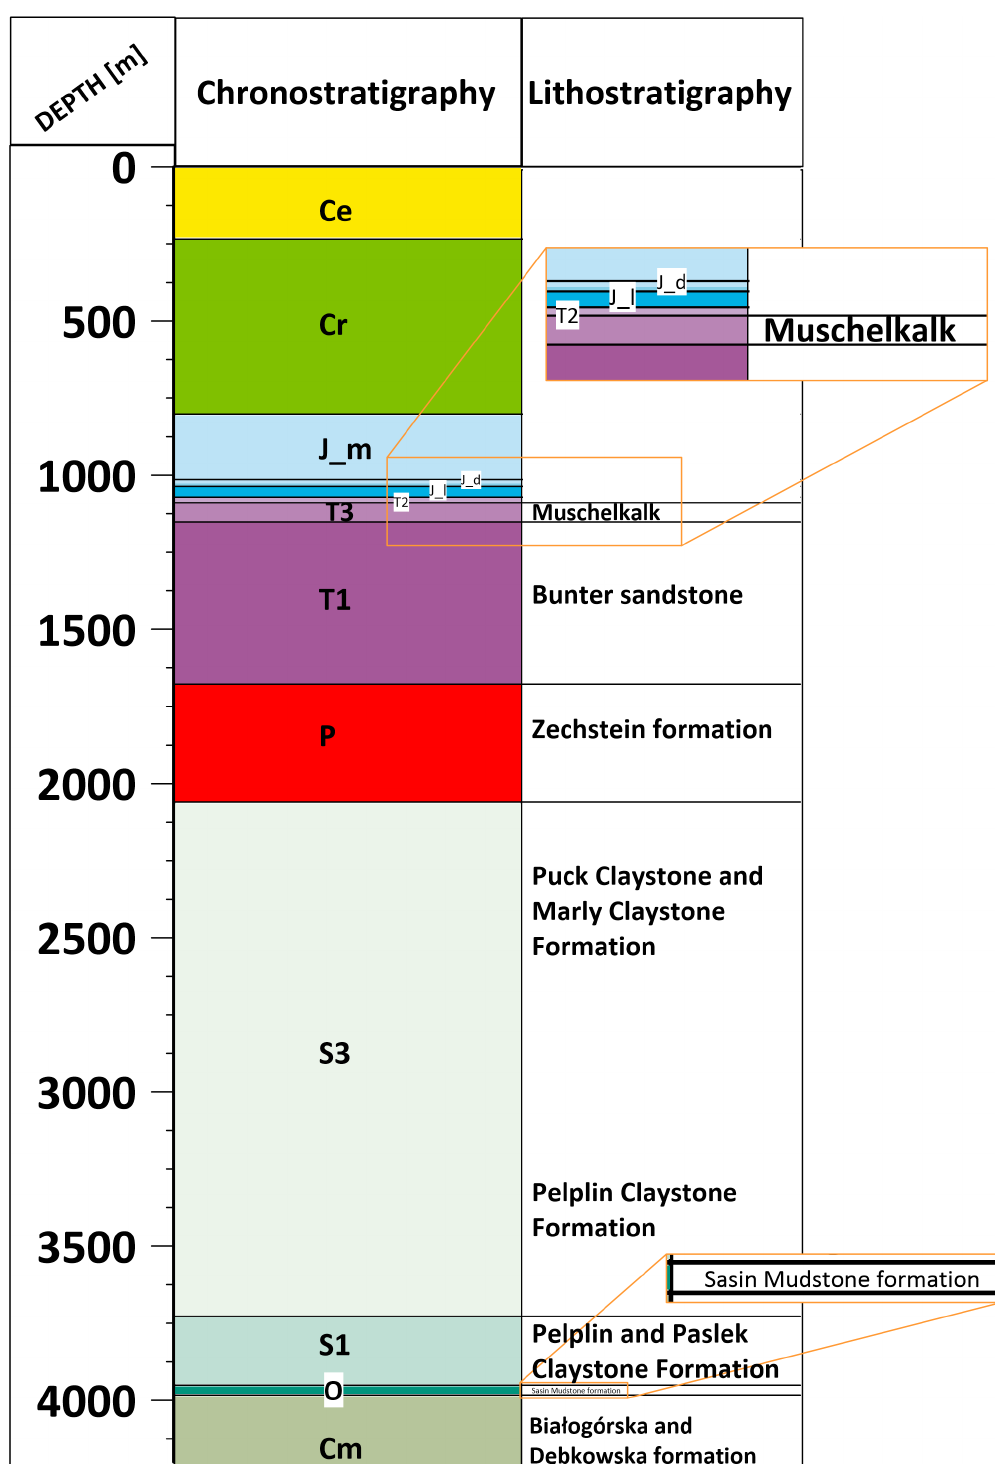
Figure 2. Chronostratigraphic and lithostratigraphic units in well W-1. Cm—Cambrian, O—Ordovician, S1—Lower Silurian, S3—Upper Silurian, P—Permian, T1—Lower Triassic, T2—Middle Triassic, T3—Upper Triassic, J_l—Lias (Early Jurassic), J_d—Dogger (Middle Jurassic), J_m—Malm (Upper Jurassic), Cr—Cretaceous, Ce—Cenozoic (based on core information from Well